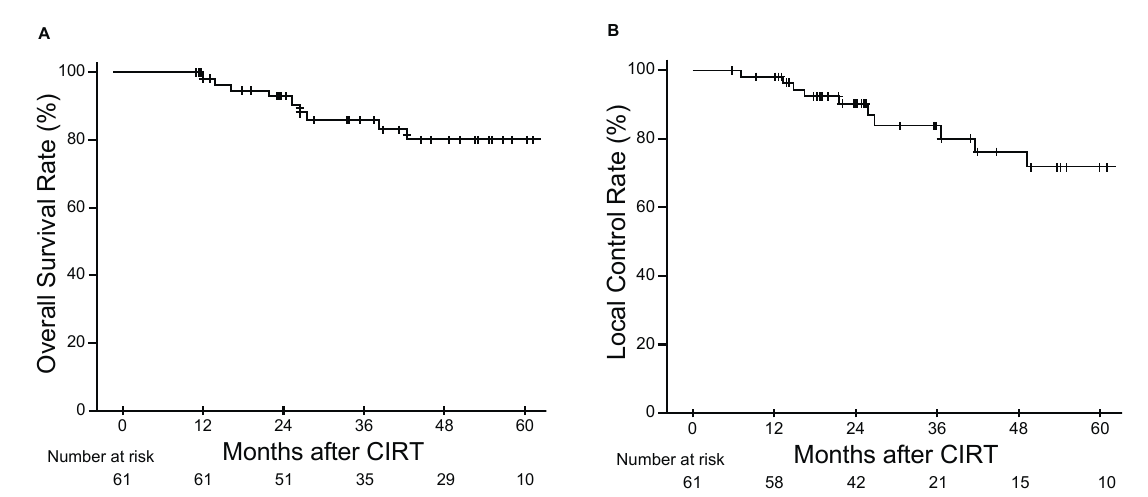
Figure 1. Kaplan-Meier estimates of overall survival ( A ) and local control ( B ) rates.